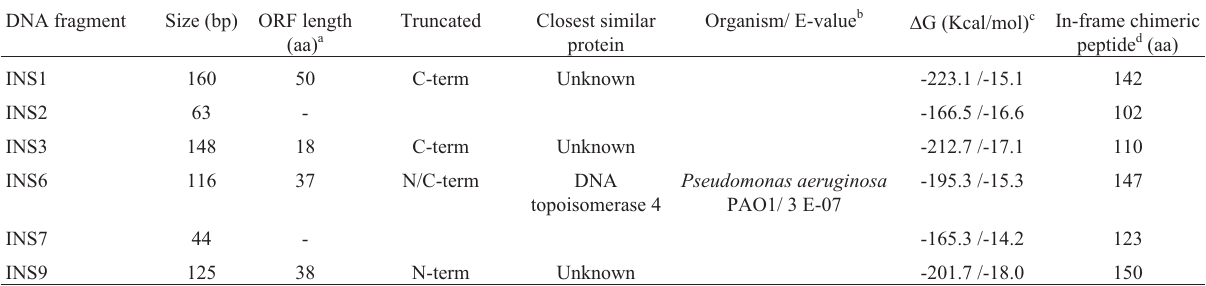
Table 2 - Metagenomic fragments contained in plasmid recovered from positive clones and their sequence features. DNA